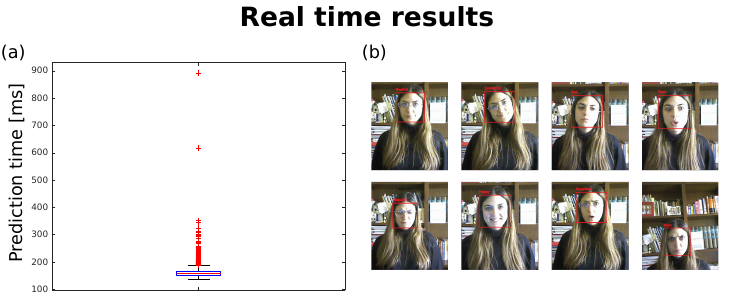
Figure 9. The real-time results: ( a ) The entire distribution of the prediction time; ( b ) Illustrative examples of the detected